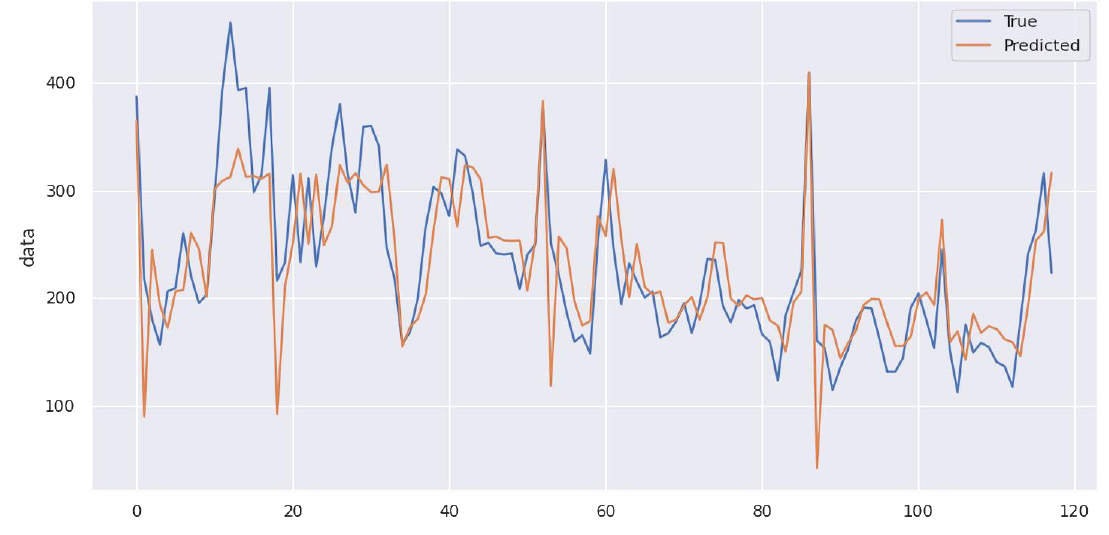
Figure 5. Graph of actual comparison data with